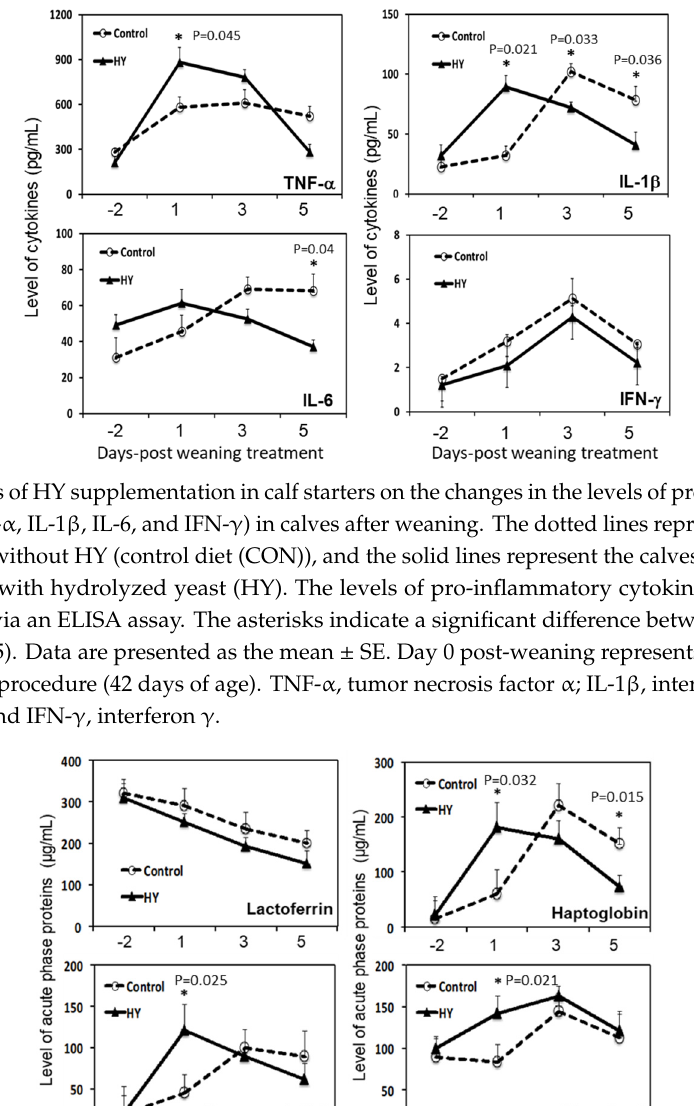
Figure 2. Effects of HY supplementation in calf starters on the changes in the levels of pro- inflammatory cytokines (TNF- α , IL-1 β , IL-6, and IFN- γ ) in calves after weaning. The dotted lines represent the calves fed calf starter without HY (control diet (CON)), and the solid lines represent the calves fed calf starter supplemented with hydrolyzed yeast (HY). The levels of pro-inflammatory cytokines in the blood were assessed via an ELISA assay. The asterisks indicate a significant difference between the dietary groups ( p < 0.05). Data are presented as the mean ± SE. Day 0 post-weaning represents the beginning of the weaning procedure (42 days of age). TNF- α , tumor necrosis factor α ; IL-1 β , interleukin 1 β ; IL-6, interleukin 6; and IFN- γ , interferon γ .